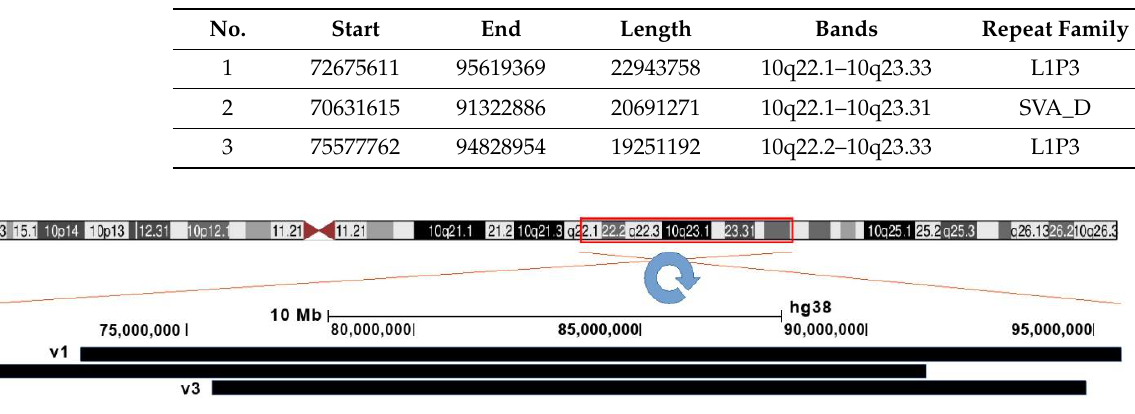
Figure 12. Three possible versions of inv(10) localization. The inverted region is marked by the red frame. Putative inverted regions are indicated by black bars: V1, V2, and V3. Table 1. Presumed breakpoints of inv(10) with genomic coordinates according to hg38.